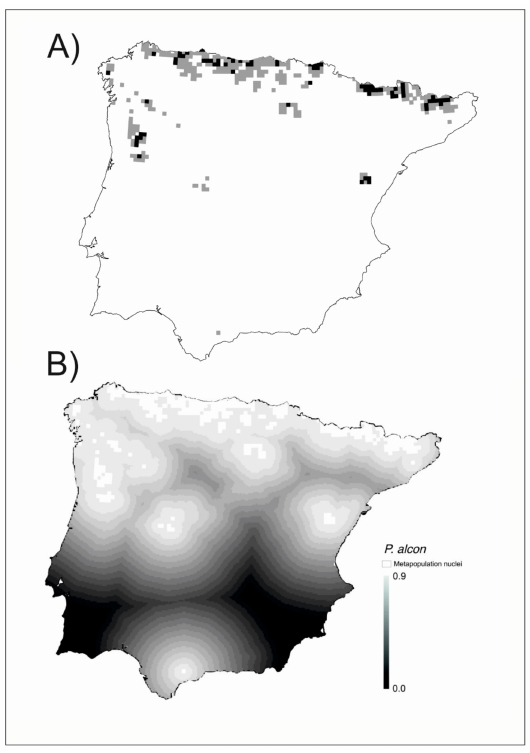
Figure 4. ( A ) Metapopulation patches of Phengaris alcon . In black, the grids with high favorability (F ≥ 0.8) and established presence, in grey those with high favorability (F ≥ 0.8) and undetected presence ( B ) Connectivity gradient between metapopulation nuclei (white plots). The matrix has been graded on a scale of eighteen levels of connectivity with a 0.05 connectivity range each (represented in